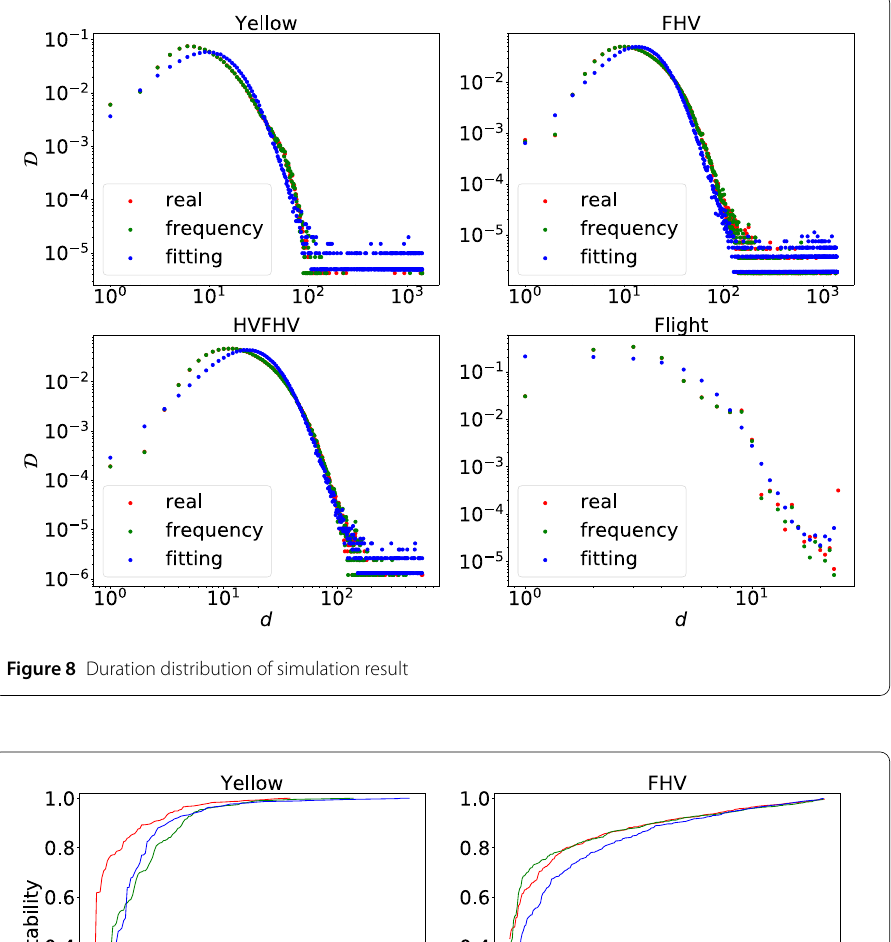
Figure 8 Duration distribution of simulation result